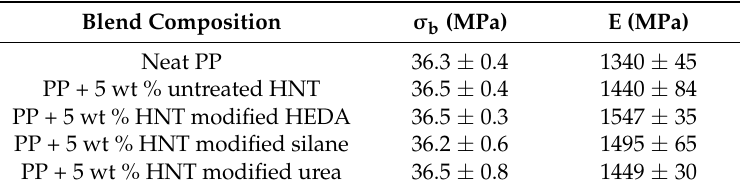
Table 3. Effects of HEDA, silane and urea modifications on the mechanical characteristics of the HNTs/PP nanocomposites